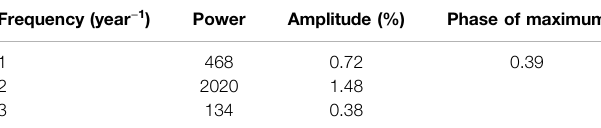
TABLE 4 | The annual oscillation and the leading two harmonics as derived from the midnight-centered measurements. Table adobted from [28].